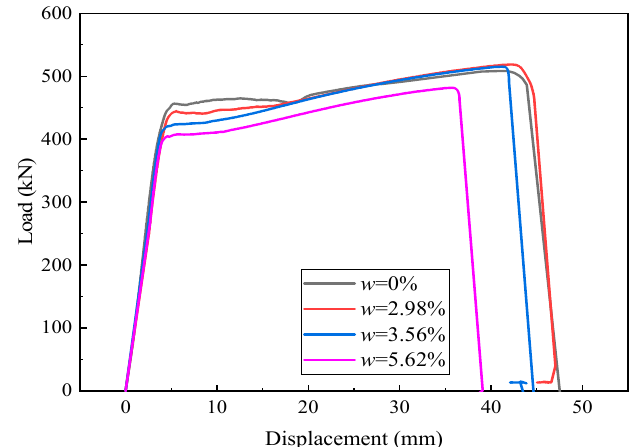
Figure 11 and Table 7 show the load-displacement curves and key mechanical parame- ters of the bolt-sphere joints with members. It can be seen that there are almost no changes in the tensile stiffness of the bolt-sphere joints with members; that is, corrosion has little effect on the tensile stiffnesses of the bolt-sphere joints with members. The yield load and yield displacement of the bolt-sphere joints with members decrease with the increase in the degree of corrosion. When the degree of corrosion reaches 5.62%, the tensile yield load of the joint decreases by 47.6 kN, which is 10.46% of the joint without corrosion.